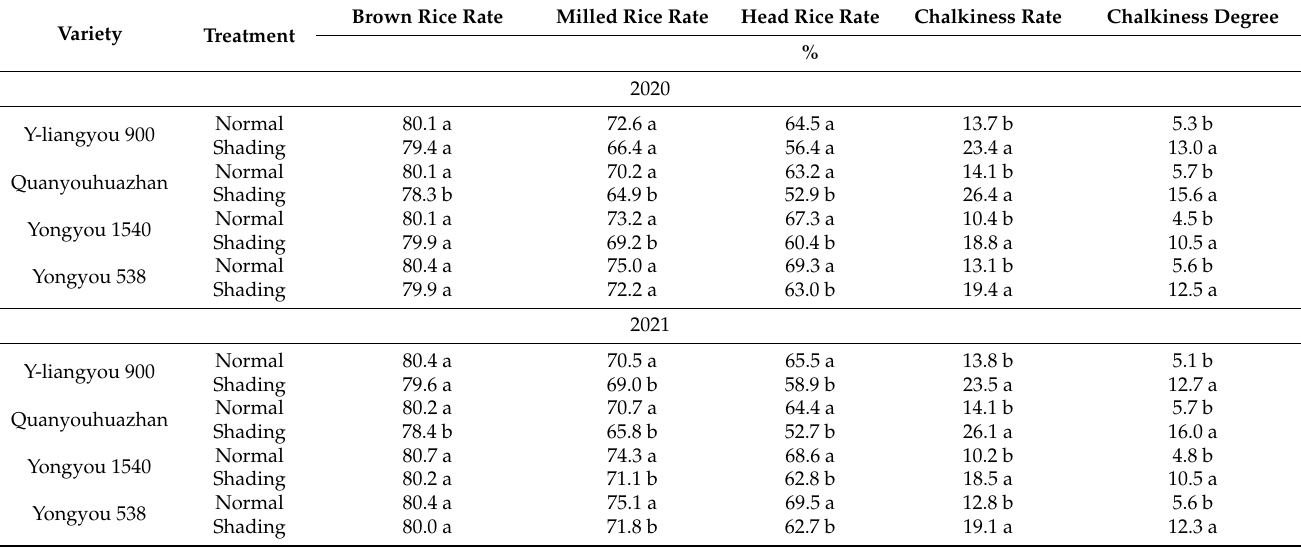
Table 3. Processing and appearance quality of different rice varieties under shading after flowering in 2020–2021.